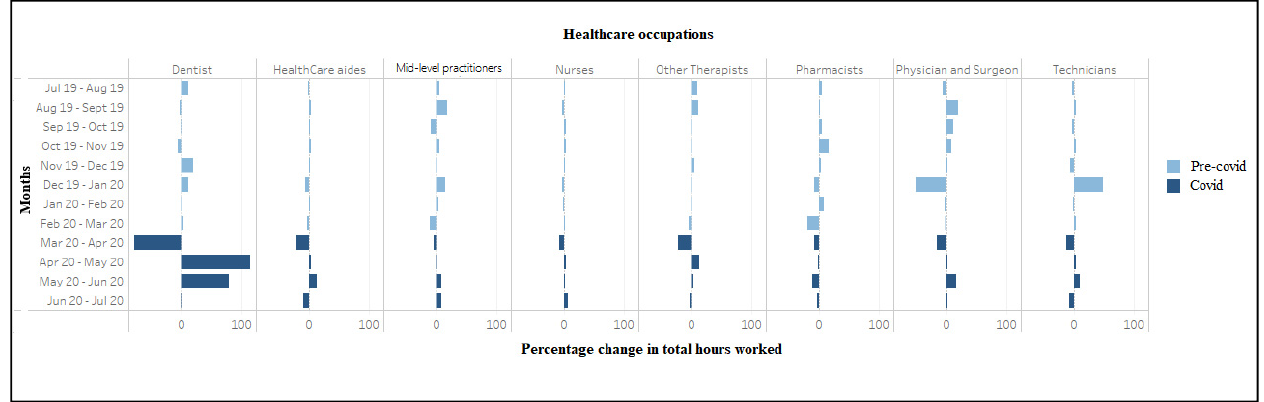
Figure A2. Percentage change in total hours worked by workers in healthcare occupations (July 2019–2020).